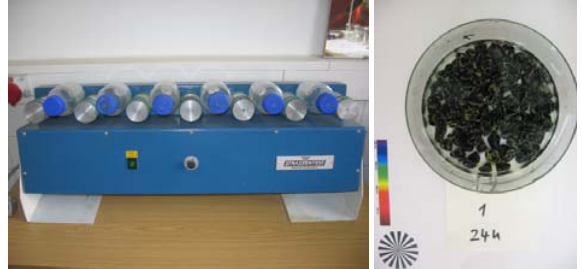
Figure 1: Rolling-bottle test. Left: rolling device. Right: sample for visual